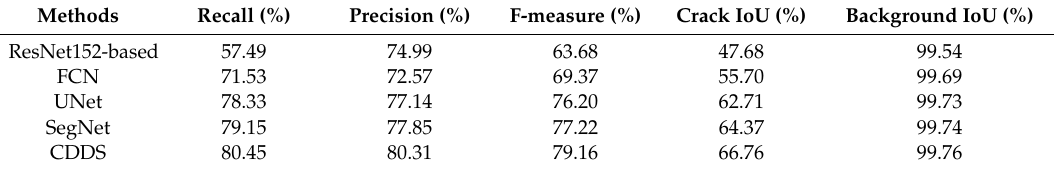
Figure 16. Examples of comparison of prediction results. (A represents FCN, B represents UNet, C represents SegNet, D represents ResNet152-based and E represents the proposed method). Table 4. Comparison of indicator parameters for ResNet152-based, FCN, Unet, SegNet and CDDS.